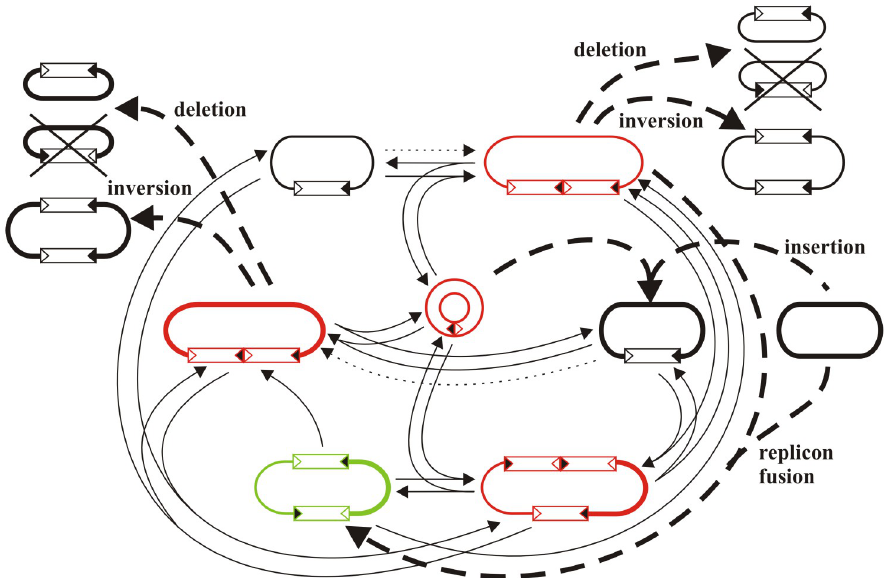
Fig 5. The dynamic model of IS 30 transposition. The model integrates the results of this work and those published previously [18–22].The reversible IR-targeting events (shown by thin arrows) always produce molecule species that carry an active IR-IR junction (shown as red) and define a closed circuit. HS-targeting events (shown by thick dashed arrows) provide the break-out pathways and produce the “classical” transposition products, like insertion, deletion, inversion, or replicon fusion (shown as black). These rearrangements are irreversible and produce stable molecule species. One of the two deletion products generally has no replication origin, so it is not detectable (crossed out). Dotted arrows represent consecutive steps of a non-transpositional (formation of dimer replicon by homologous recombination or partial replication) and a transpositional (SSD) process resulting in an IS-dimer. Note that minicircles do not only derive as products of DDSs, but can emerge from any IS-containing replicon via an SSD reaction (not indicated) [16, 19]. Apart from minicircles and some deletion products most components of the network can replicate and survive even many cell cycles ensuring that many different plasmid species and/or chromosome can occur in the same bacterial population. The classical cointegrate structure (shown as green) may have an important role in maintaining the network. It is stable enough to spread in the whole population and can produce active structures (IS-dimer) via a single SSD reaction, by which it can be the start point of bursts of rearrangements in different cells in the